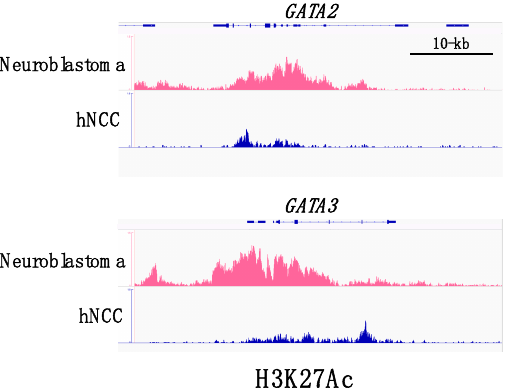
Figure 2. ChIP-seq (chromatin immune-precipitation sequencing) profiles for H3K27ac binding at GATA2 and GATA3 super-enhancers. GATA2 and GATA3 loci in neuroblastoma cells are associated with dense accumulation of H3K27ac in comparison with the loci in normal human neural crest cells (hNCC). Datasets are derived from SRX2911572 (human neural crest cells) and SRX5705566 (human neuroblastoma cells).